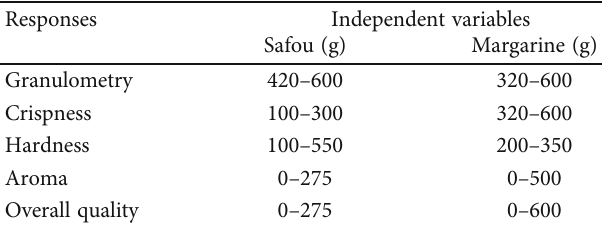
Figure 3: E ff ect of the quantity of margarine and safou powder on the hardness (a), aroma (b), and overall quality (c) of safou rice Table 4: Optimal conditions of biscuits production.